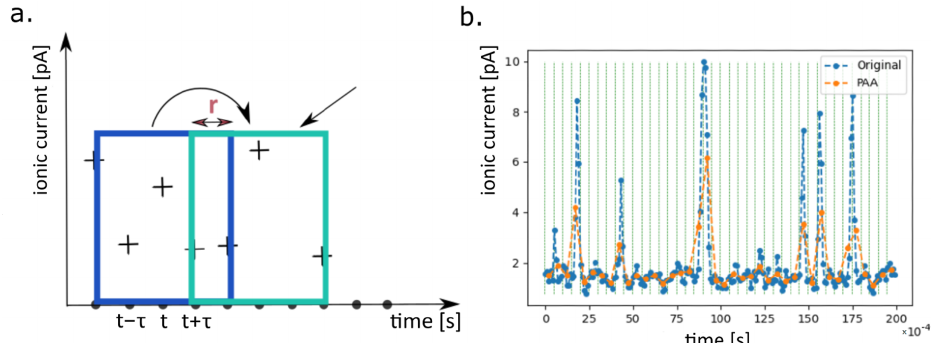
Figure 5. ( a ) Illustration of the time series split. In the current analysis the r = 200. ( b ) A schematic representation of the PAA method. Each original subseries of 1000 data points (which corresponds to the time interval of 0.1 s at the applied sampling rate of 10 kHz) is “compressed” to the series of 200 points by the PAA algorithm of dimensionality reduction. Here, for clarity we presented the dimensionality reduction performed on the original subseries of 200 points (corresponding to the time interval 0.02 s). As one can see, application of PAA algorithm allow the retention of the main features of the original input